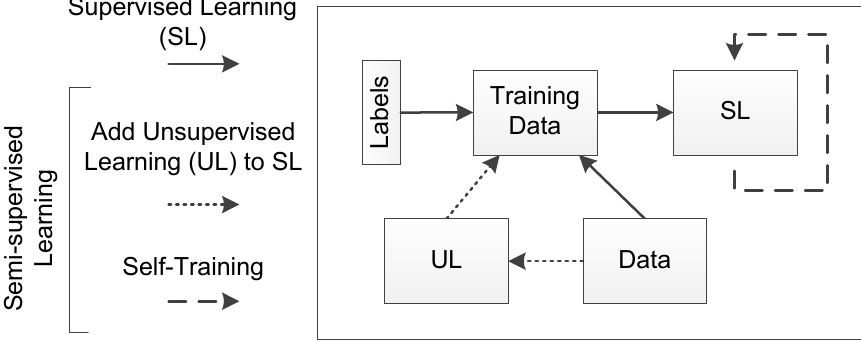
Figure 1. Relation of semi-supervised learning (SSL) approaches to standard supervised learning.